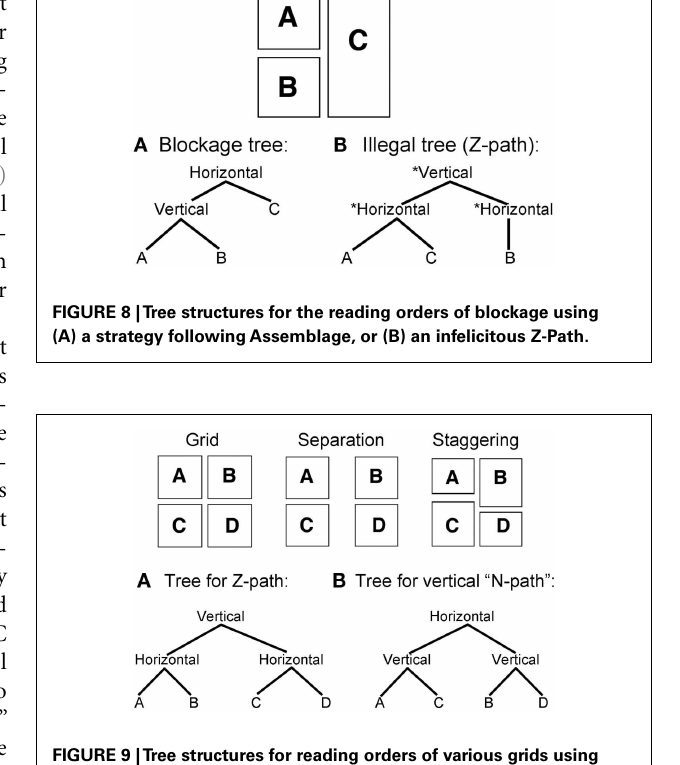
FIGURE 9 |Tree structures for reading orders of various grids using (A) a strategy following the Z-path, or (B) a strategy going against the Z-path (for a vertical